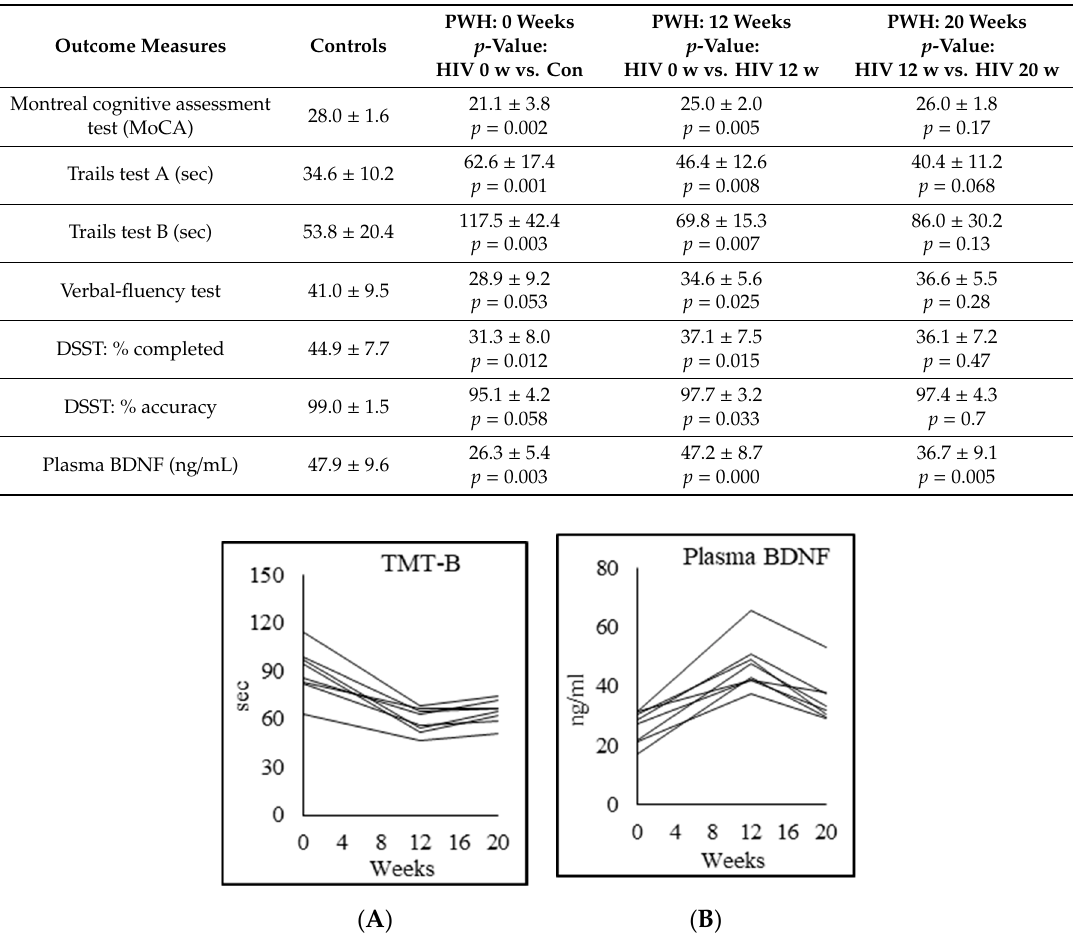
Figure6. Individualparticipantdatashowing( A )Trails-Btestvaluesand( B Figure 6. Individual participant data showing ( A ) Trails-B test values and ( B ) fasting plasma BDNF concentrations.